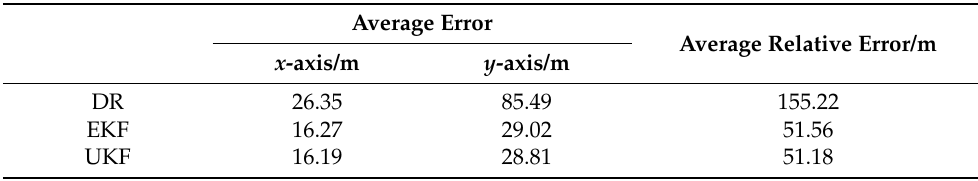
Table 6. Co-navigation test error